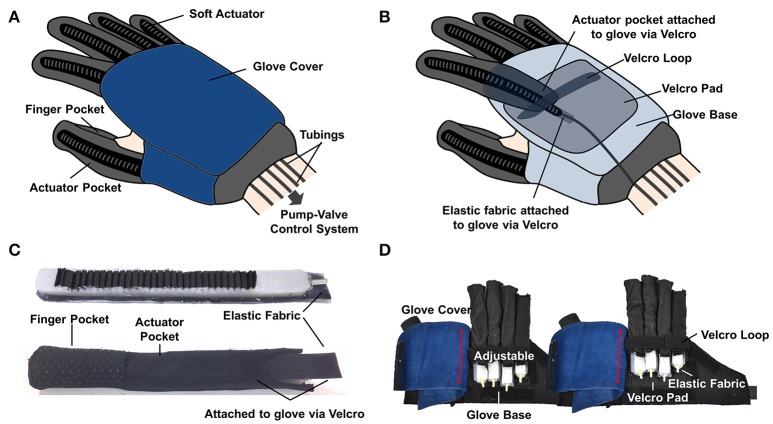
(A) Outer view and (B) inner view of the soft robotic glove. (C) Actuators are inserted into actuator pockets. (D) The length of the finger-actuator pockets can be adjusted and attached to the base of the glove via Velcro.